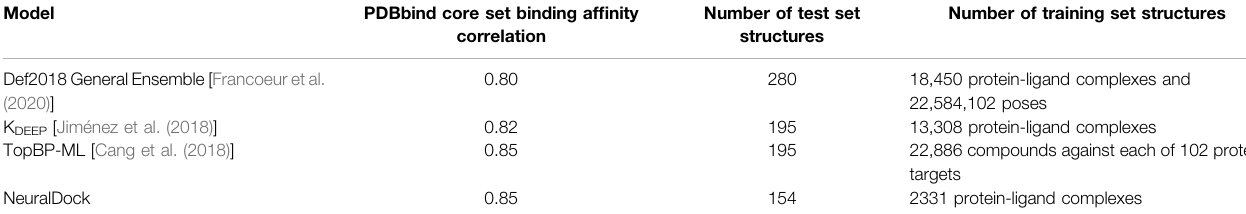
TABLE 2 | Correlation coef fi cients for binding af fi nity prediction of a variety of neural networks. Model